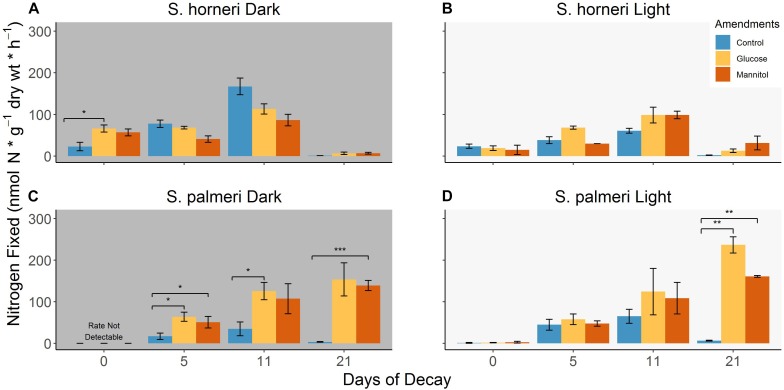
(A–D) Differences in BNF rates associated with decomposing S. horneri and S. palmeri between control conditions, glucose (100 μM/1 mM) and mannitol (100 μM/1 mM) additions under dark and light incubations (error bars represent SE). ∗p < 0.05, ∗∗p < 0.01, ∗∗∗p < 0.001.